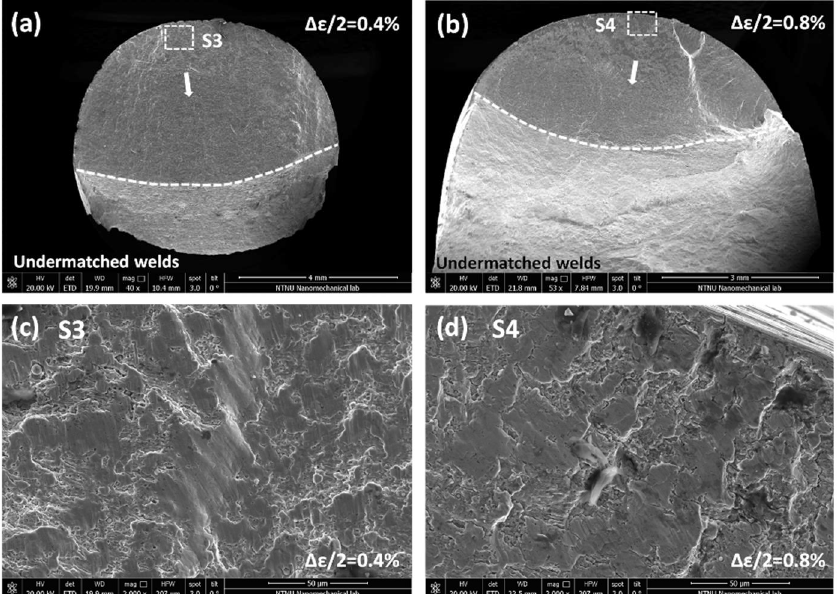
Figure 17. SEM fracture images, under strain amplitudes 0.4% and 0.8% of undermatched welds. ( a ) over fracture surface under 0.4%; ( b ) over fracture surface under 0.8%; ( c ) crack propagation near crack origin under 0.4%; ( d ) crack origin under 0.8%.